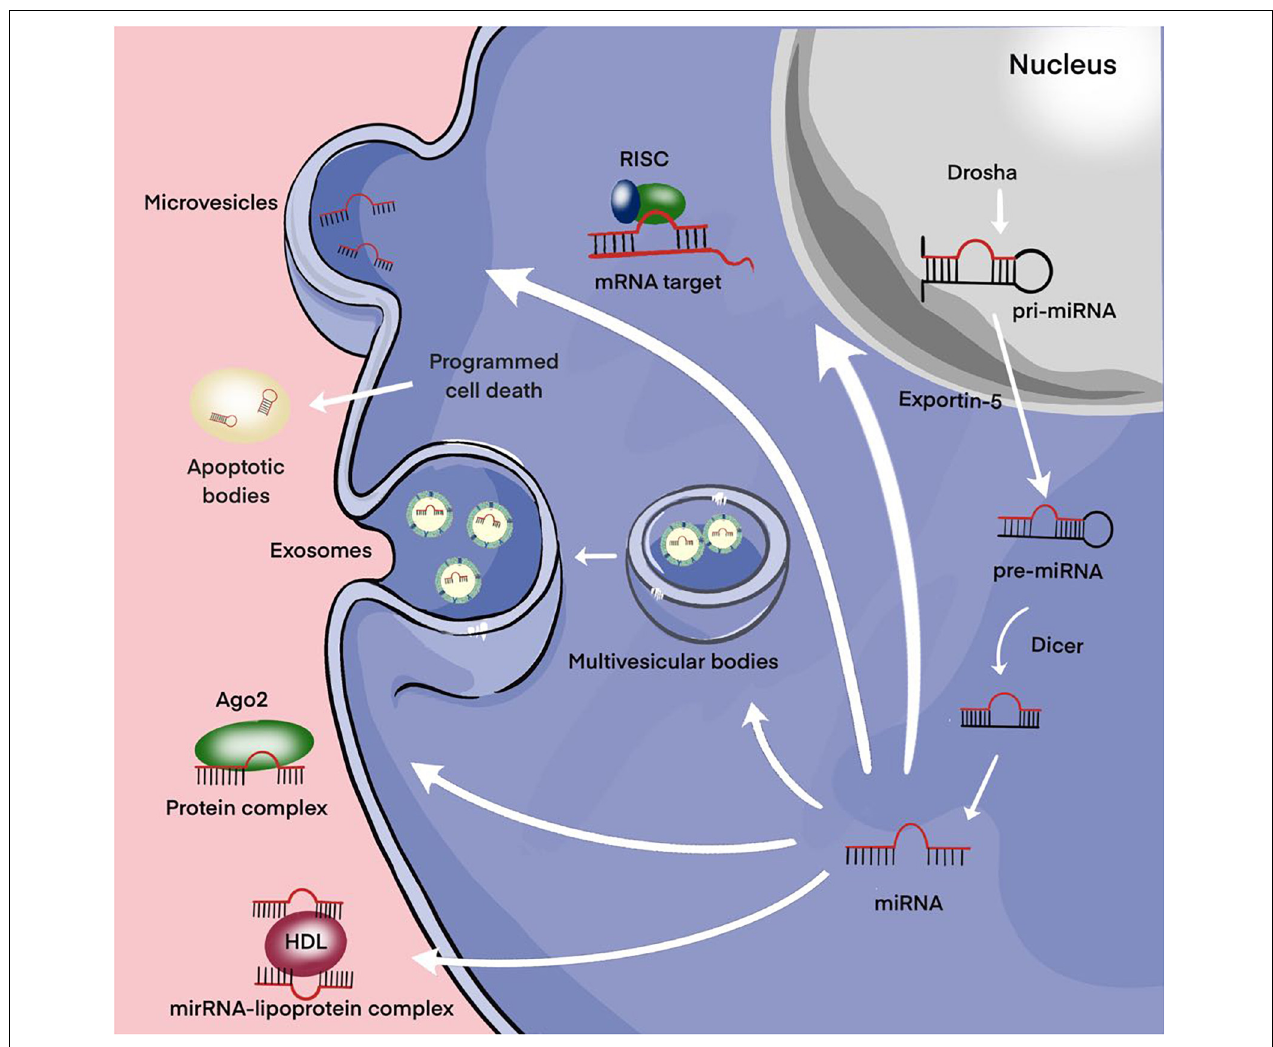
FIGURE 3 | Secretion of miRNAs into the extracellular environment. Primary microRNA (pri-miRNAs) are transcribed by RNA polymerase II and then processed by Drosha into precursor-miRNAs (pre-miRNAs). Exportin5 transfers these pre-miRNAs from the nucleus to the cytoplasm, where Dicer converts them into mature miRNAs. Mature miRNAs can be selectively incorporated into extracellular vesicles (EVs) (exosomes and microvesicles) or linked to the Argonaute 2 (Ago2) protein and released into the extracellular environment. Alternatively, they can be attached to high-density lipoprotein (HDL) or contained in apoptotic bodies and then released into the extracellular